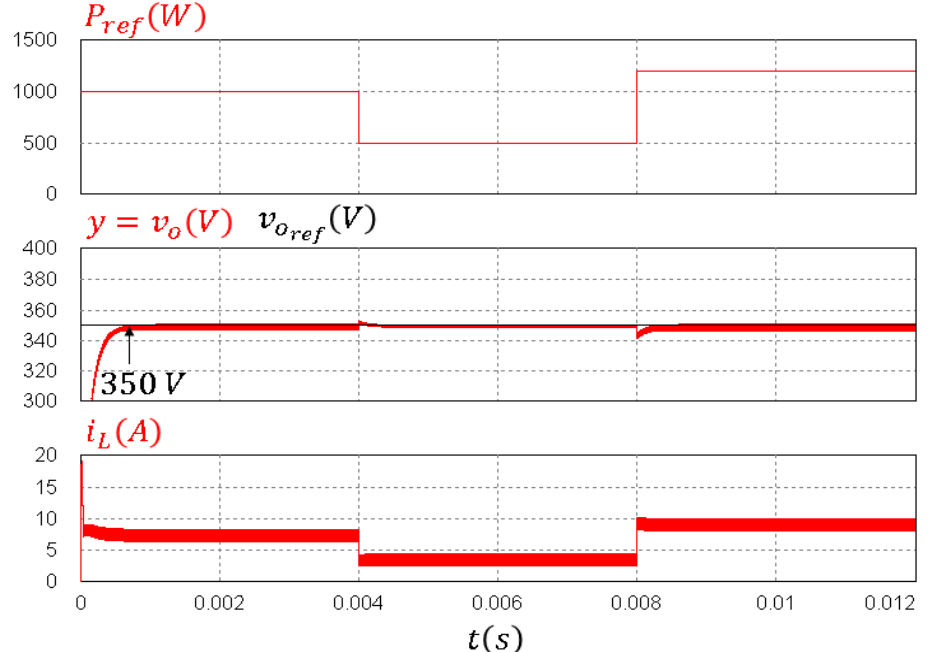
Figure 7. Response to disturbances in the output power P ref . Case 3: Constant power at the output and variable input